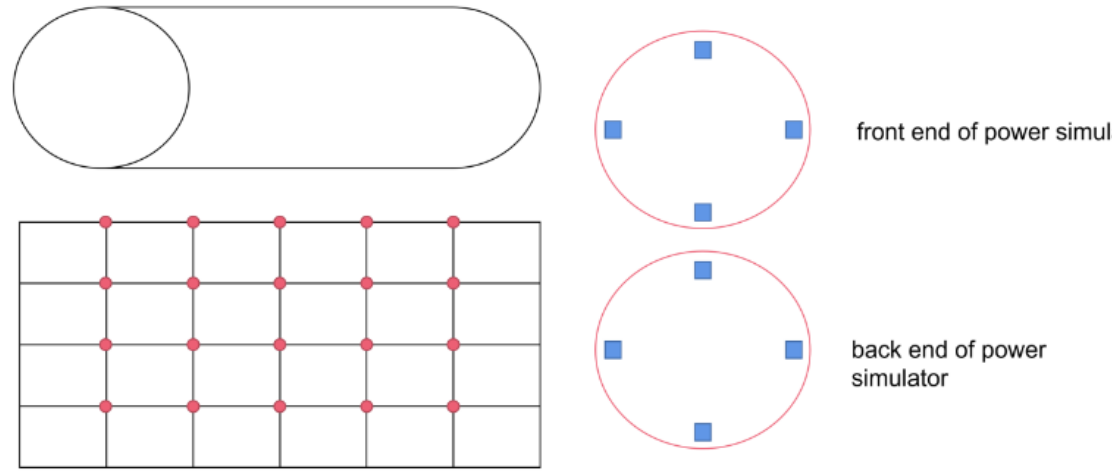
Figure 3. Acceleration measuring point distribution diagram of the housing and power plant simulator.